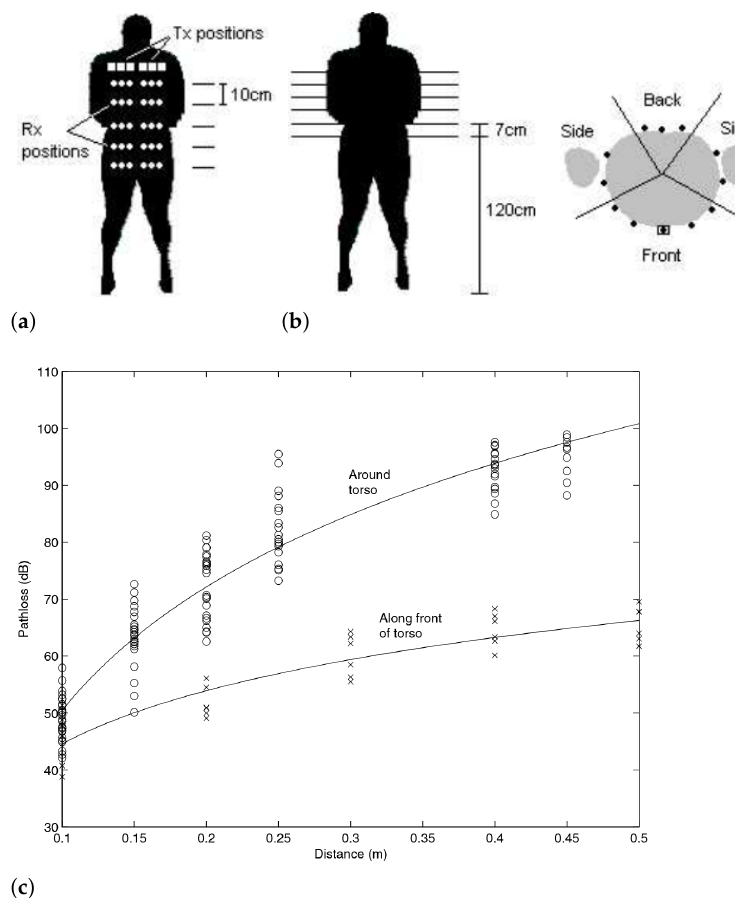
Figure 26. On-body placement of the sensing nodes ( a ) along the torso and ( b ) around the torso. ( c ) Measurement of the path loss (dB) as a function of the distance (m) between the sensing nodes around the torso (top line) and along the torso (bottom line). From